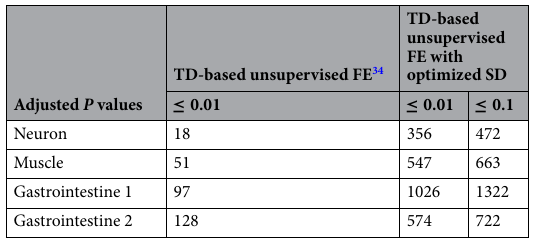
Table 8. Comparison of selected genes between TD-based unsupervised FE 34 and optimal SD with multi- organ data